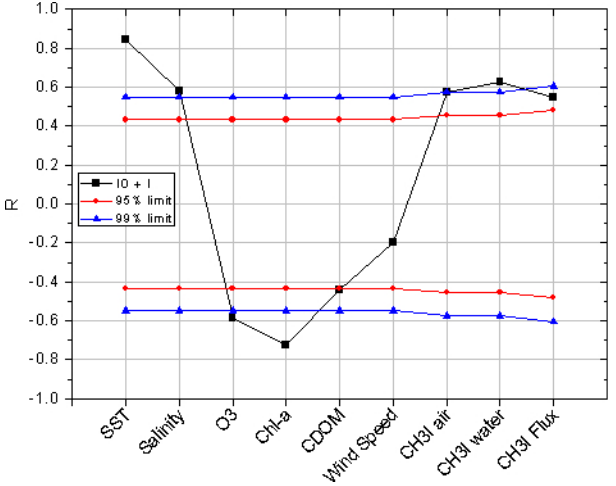
Fig. 6. Pearson correlation coefficients for IO x with individual pa- rameters, along with 95% and 99% confidence limits are shown. IO x is positively correlated with SST and salinity, CH 3 I in air and water but negatively correlated with O 3 and Chl a within the 99% confidence limits. It is also positively correlated to CH 3 I flux and negatively correlated to CDOM within 95% confidence, while no significant correlation is seen with wind